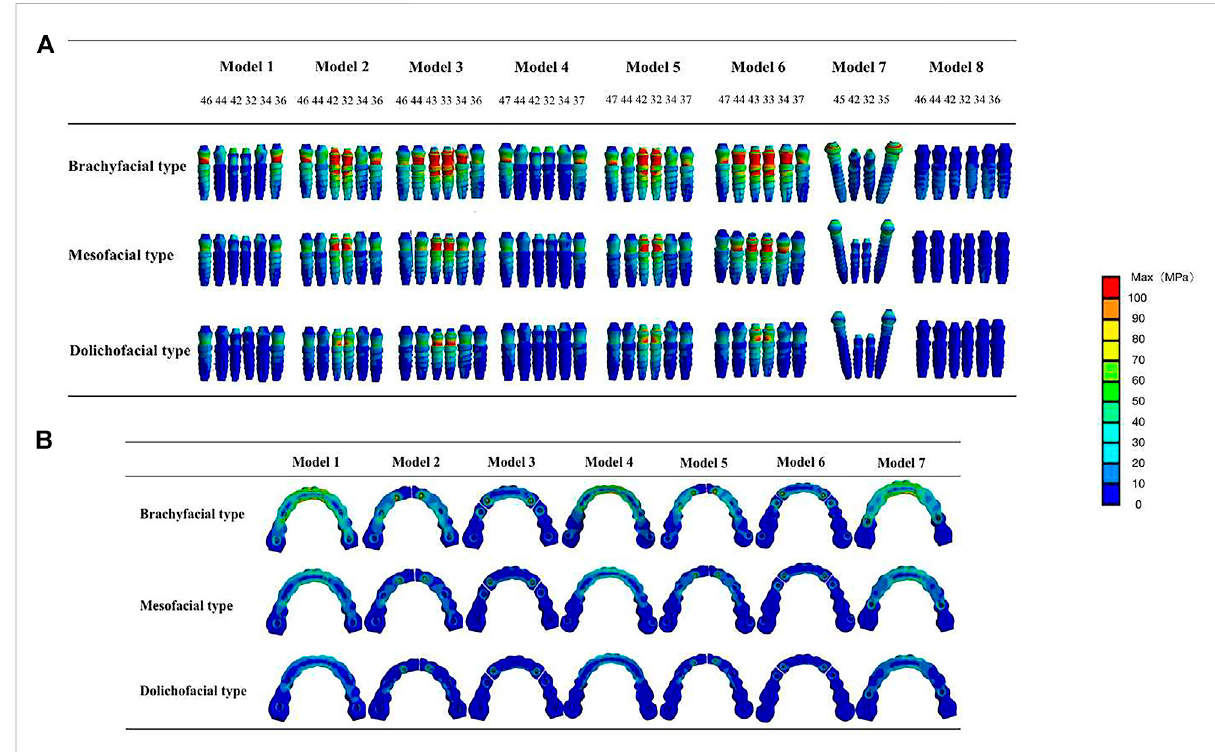
FIGURE 7 VonMisesstressesinprosthesesofdifferentfacialtypes. (A) VonMisesstressesinimplants. (B) VonMisesstressesintheframework.Thestresses in prostheses were the largest in the brachiofacial type, followed by mesofacial and dolichofacial types, but all groups represented the same displacement